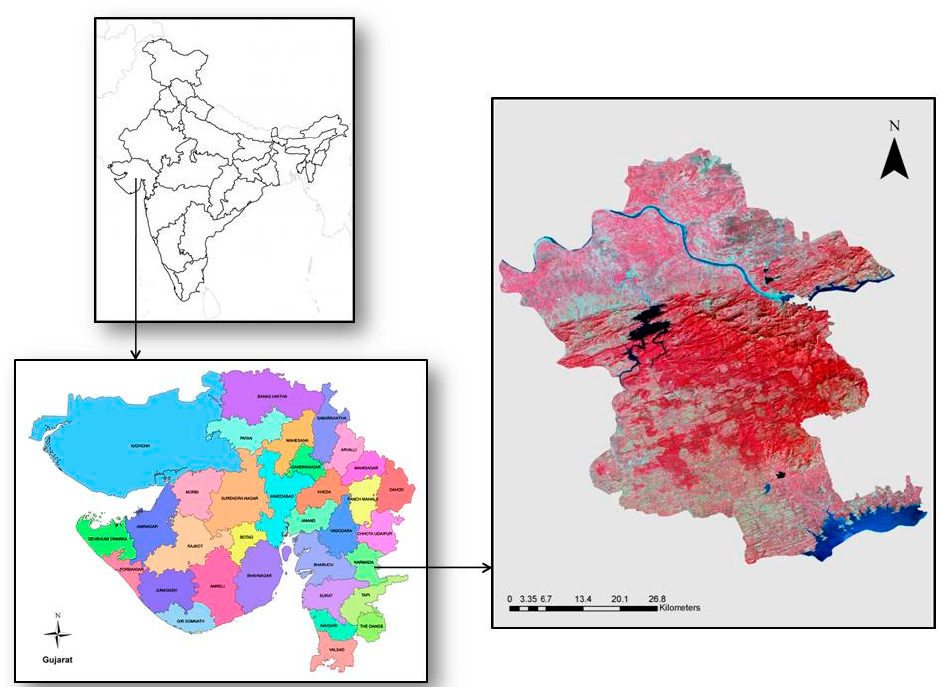
Figure 1. A location map showing the study area, Narmada district, Gujarat, India; image used in the study area map is a Landsat 11 RGB composite.